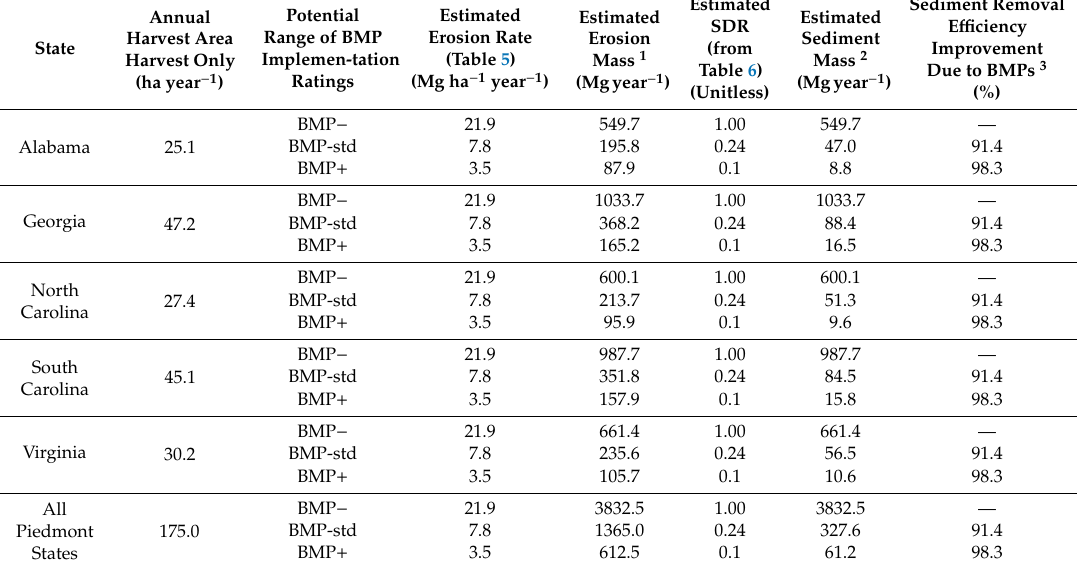
Table 11. Estimated erosion rates, erosion, masses, sediment delivery, and sediment removal e ffi ciencies due to BMP implementation levels by state for stream